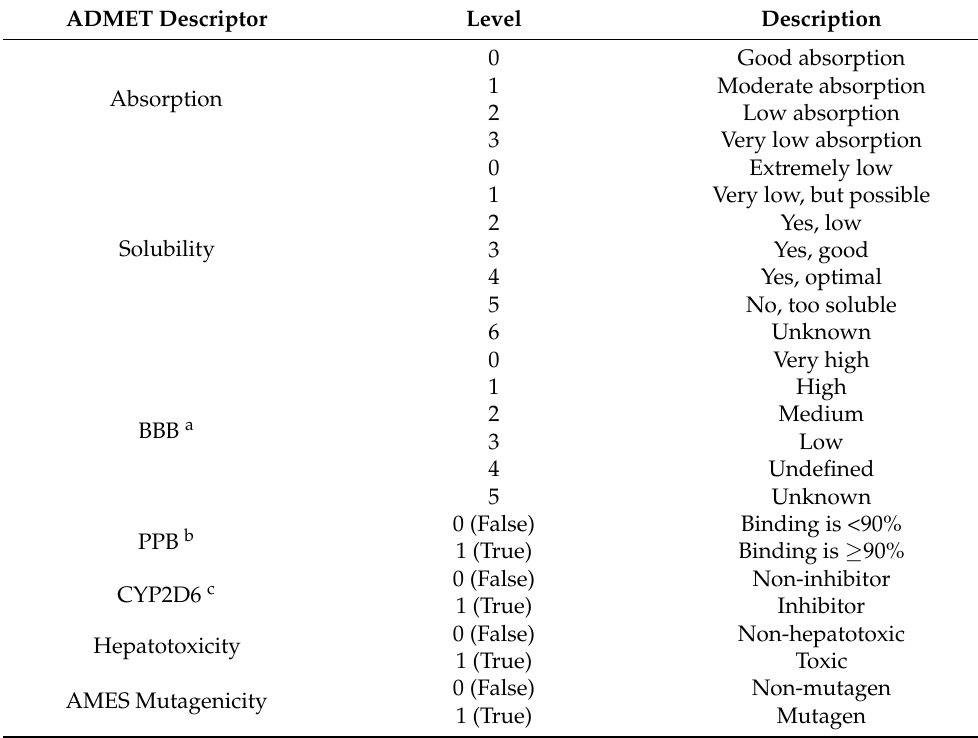
Table 6. DS 2019 guidelines for ADMET-related descriptors and mutagenicity